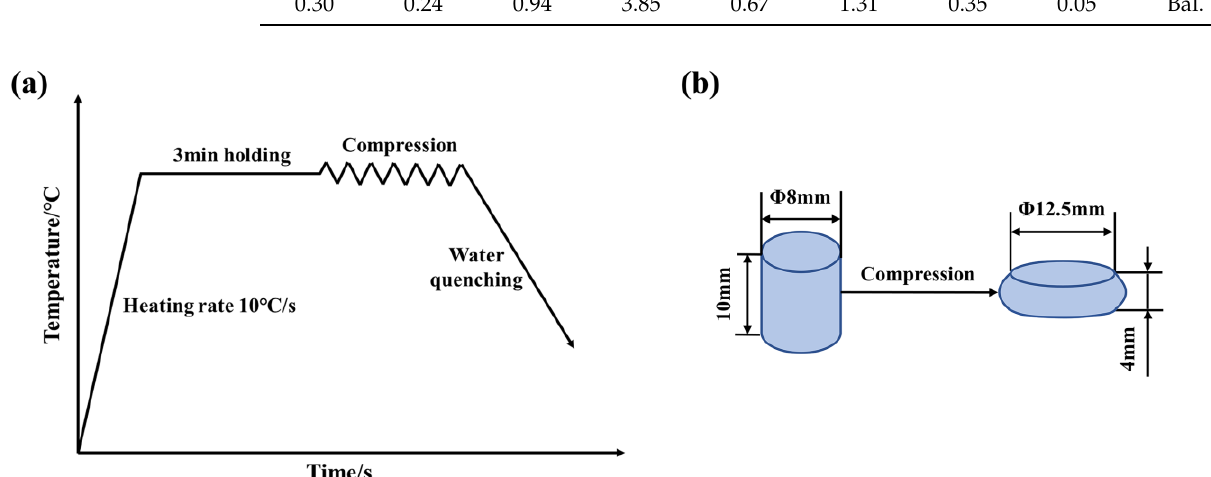
Figure 1. ( a ) Schematic diagram of the hot compression tests, ( b ) Schematic diagram of the specimens before and after compres- sion.